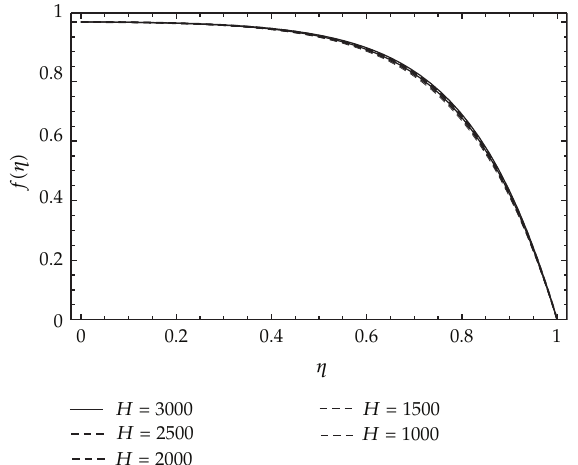
Figure 4: DTM solution for velocity in divergent channel for Re (cid:8) − 400 and α (cid:8) − 2 . 5 ◦